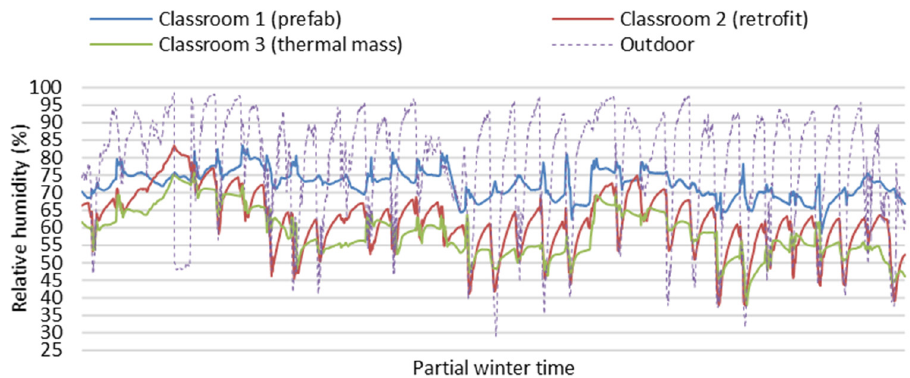
Figure 4. Field study data of indoor temperatures of the three classrooms on partial winter days (24 h per day).